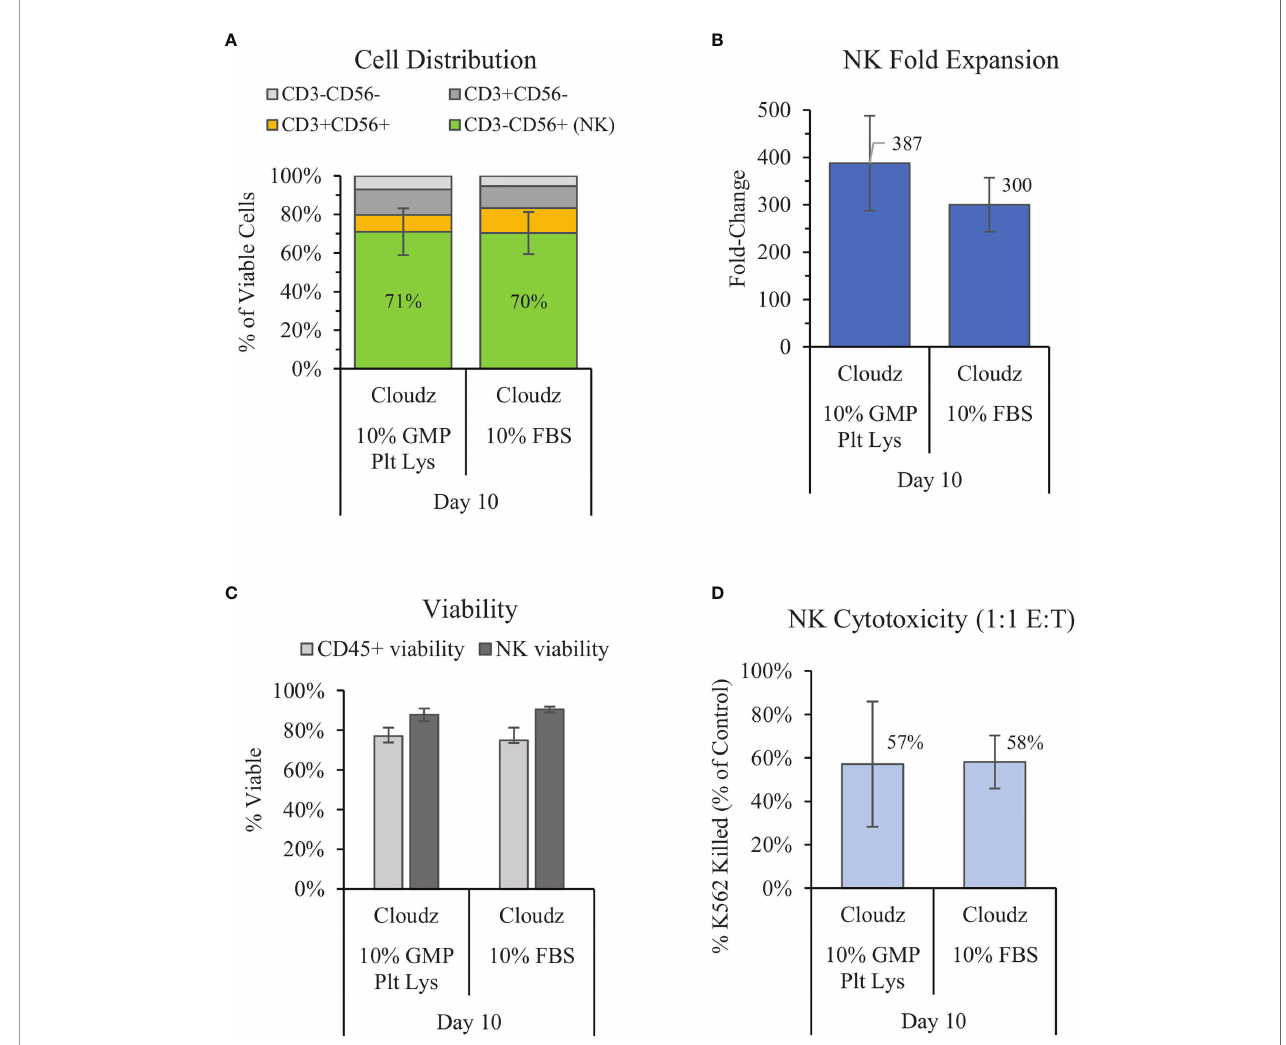
FIGURE 2 | Comparison of the xeno-free 10% GMP human platelet lysate/NK Cloudz protocol to the existing FBS/NK Cloudz protocol in the G-Rex6M. The results show (A) the cell distribution on day 10, (B) NK (CD3 − CD56 + ) fold change between days 0 and 10, (C) the viability of either all CD45 + cells or NK cells alone on day 10, and (D) the percent of target K562 cells killed on day 10 with a 1:1 effector:target (E:T) ratio and a 4 h incubation. Data represent the mean ± SD from 4 separate donors. The GMP human platelet lysate resulted in similar purity, expansion, viability, and cytotoxicity as the FBS